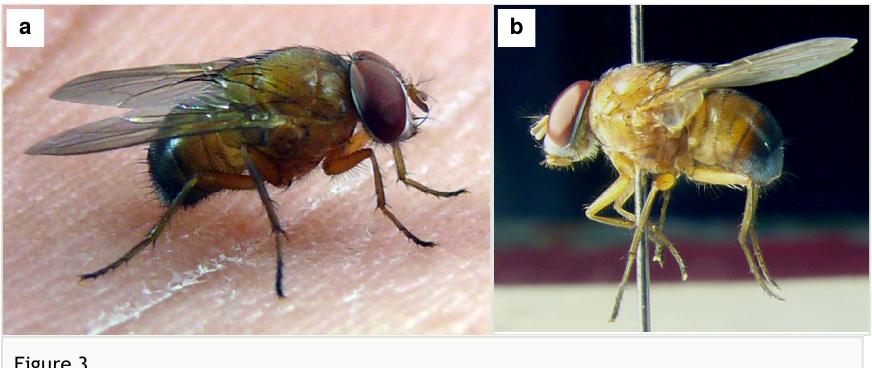
Figure 3. Caiusa adults reared from rhacophorid tree frog nests at Shyamkhola More (West Bengal,